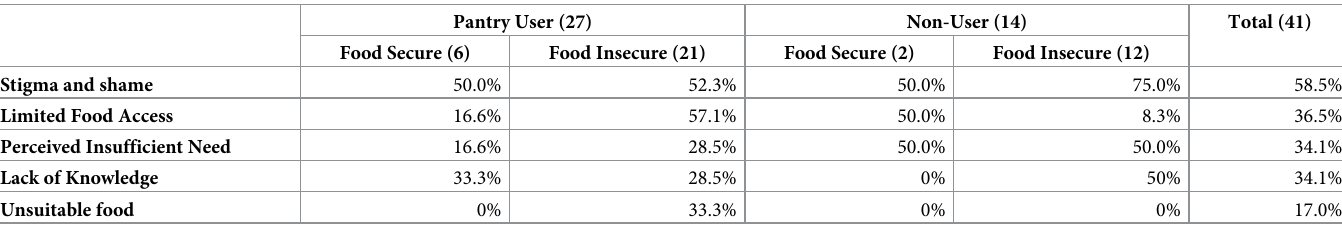
Table 3. Frequency of codes discussed as barriers by food pantry use (n =